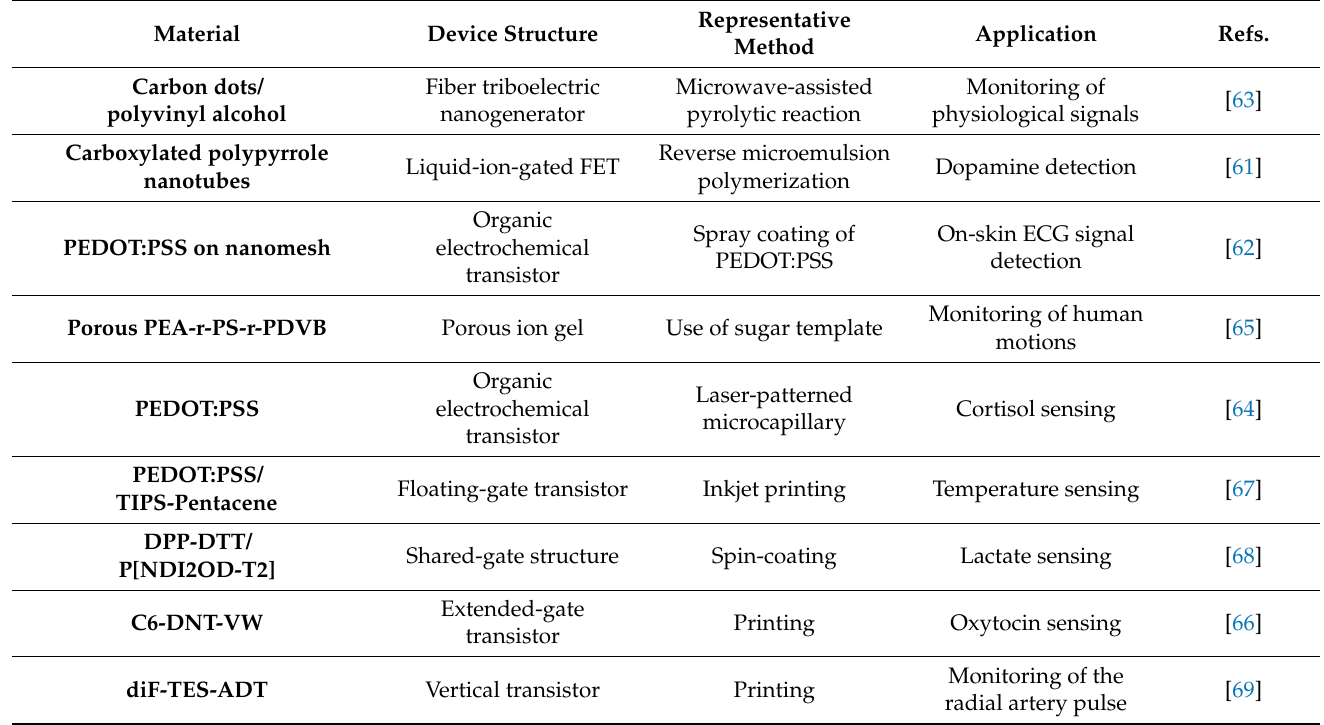
Table 2. Comparison of materials, device structures, fabrication methods, and applications in previously reported organic material-based healthcare devices.